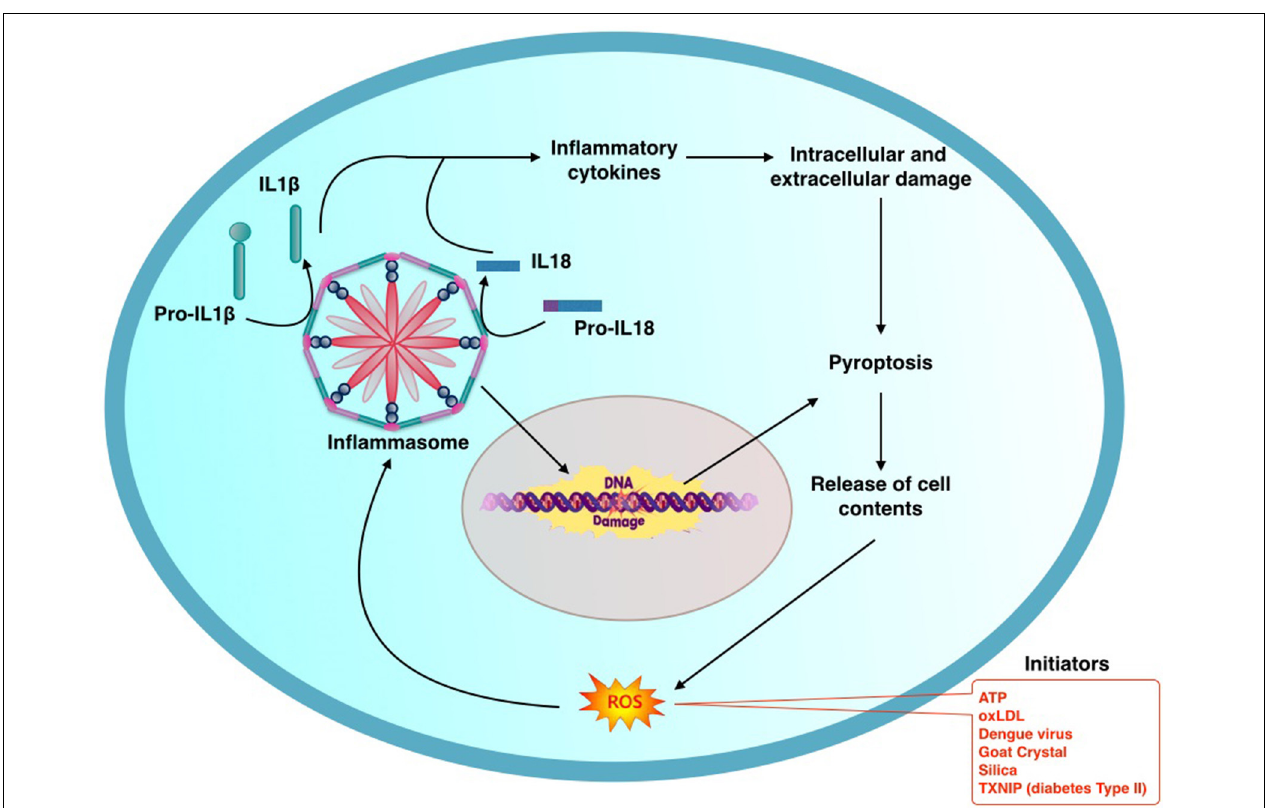
FIGURE 1 | General schema describing the process of activation of inflammasome: initiating factors activate production of reactive oxygen species (ROS) which in turntriggers the inflammasome mediated inflammatory cascade. Oligomerization of components results in assembly of Inflammasome. This in turn